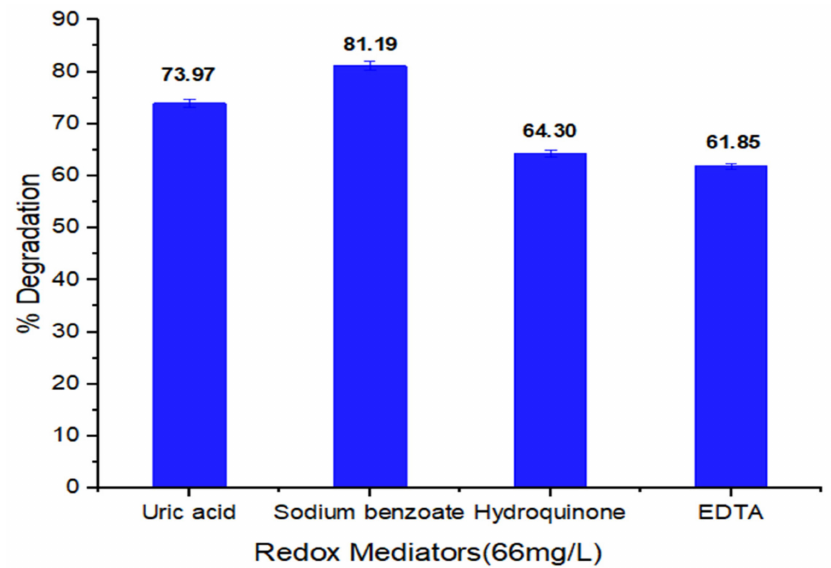
Figure 10. Effect of Redox Mediators (mg/L) on Basic Orange 2 Dye % degradation.